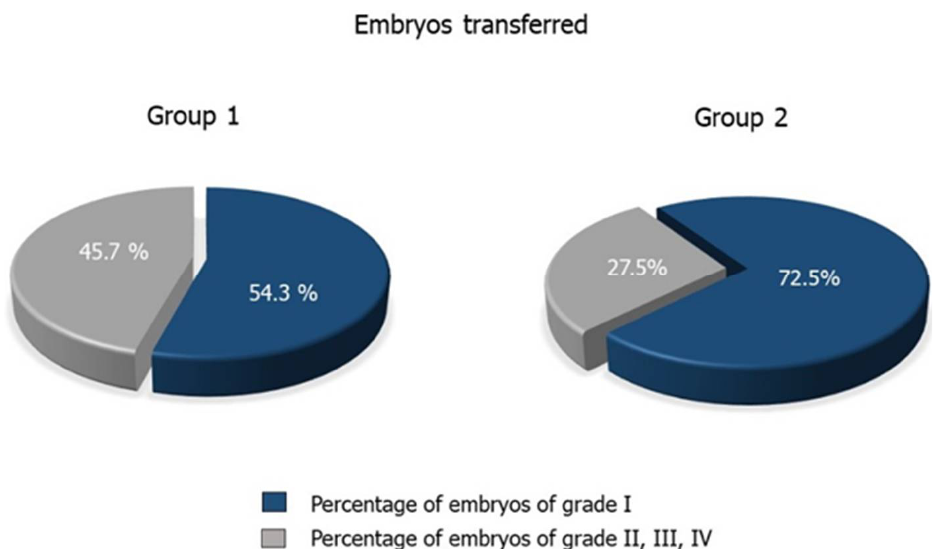
Figure 1. Embryo quality of couples in Groups 1 ( n = 223) and 2 ( n = 90).